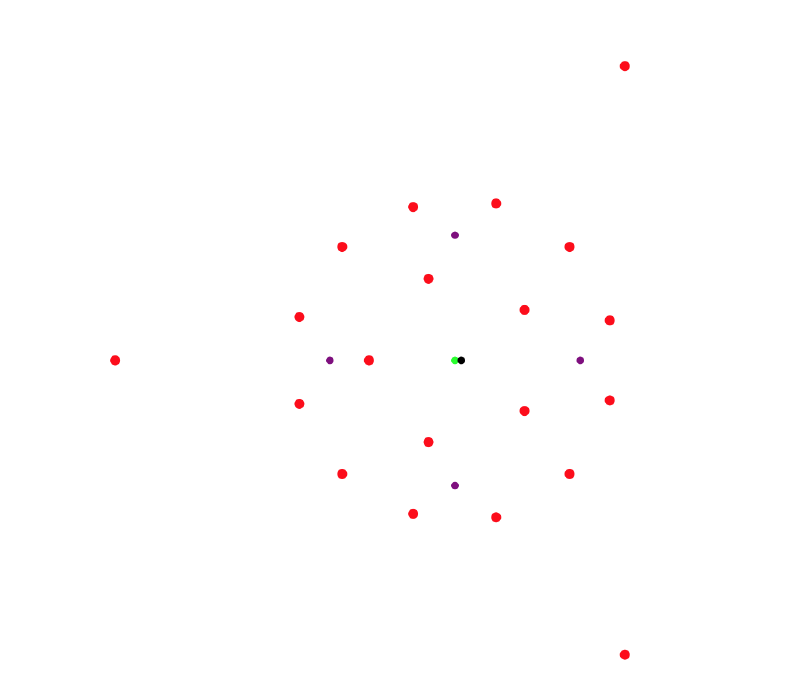
) = ( 20,17,5 ) and , n , n 1 2 3